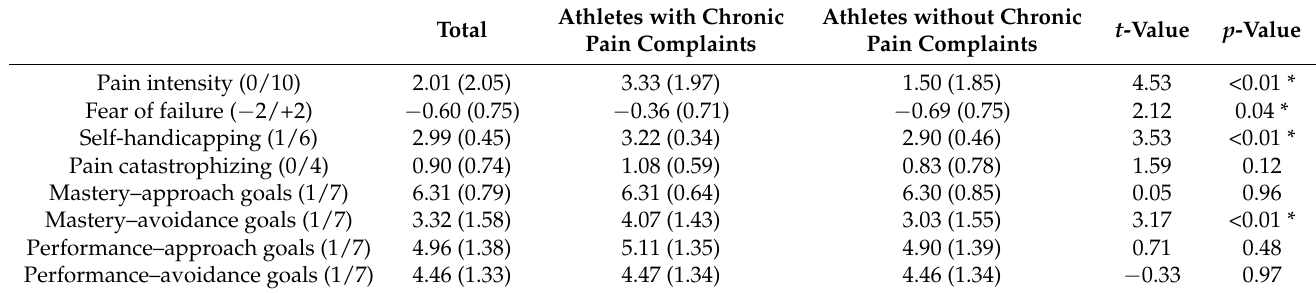
Table 2. Mean (SD) and t -test statistics for pain intensity, fear of failure, self-handicapping, pain catastrophizing and goal orientation subtypes for athletes with and without chronic pain. Athletes with Chronic Athletes without Total Pain Complaints